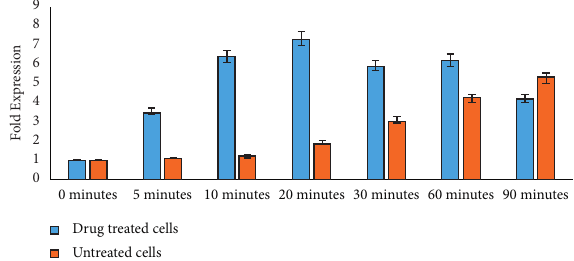
Figure 2: Transcriptomic profiling of Klebsiella pneumoniae clinical isolates under ciprofloxacin stress. The graph indicates alterations in the gene expression of euTu, dnaK, mutS, clpB, and lexA in a time-dependent manner. The X -axis represents genes, whereas the Y -axis displays the fold